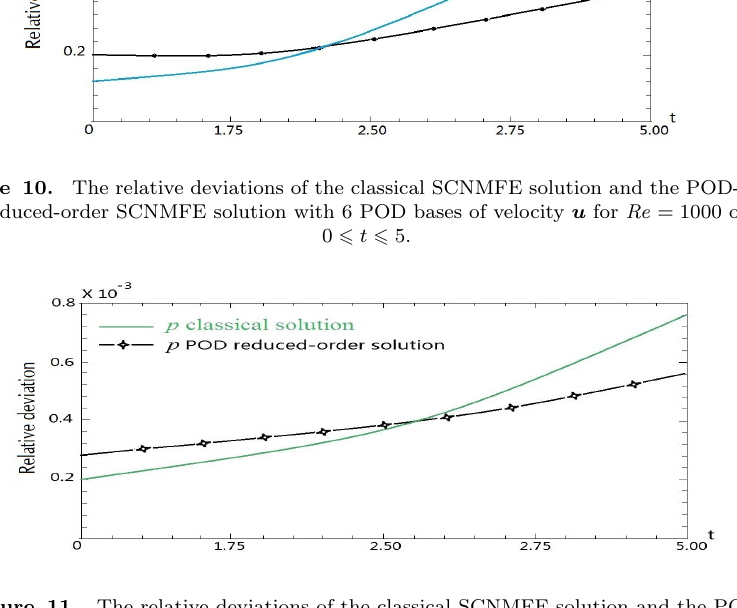
Figure 11. The relative deviations of the classical SCNMFE solution and the POD- based reduced-order SCNMFE solution with 6 POD bases of pressure p for Re = 1000 on 0 (cid:54) t (cid:54) 5.